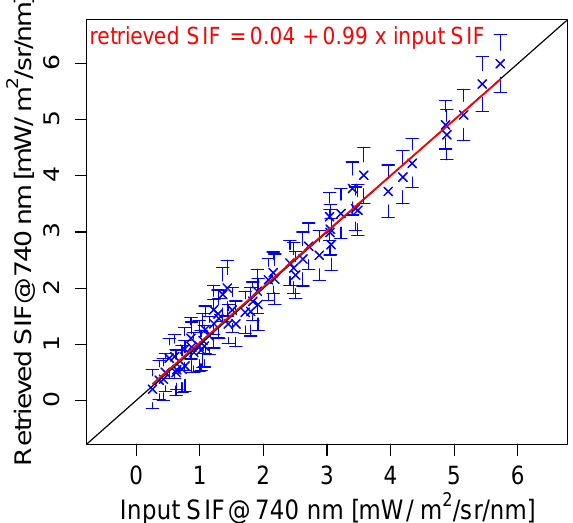
Figure 5. Input vs. retrieved SIF at 740nm of the end-to-end sim- ulation using the retrieval window from 720–758nm and providing eight PCs. The average of the retrieved SIF for each top-of-canopy (TOC) measurement is shown together with its standard deviation (error bar). A linear fit of all TOC means is shown in